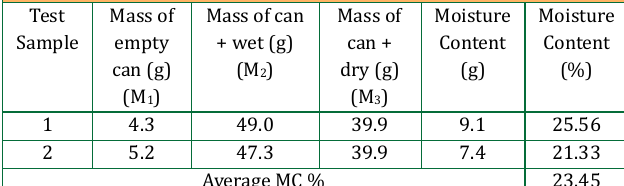
Table 2 (b): Moisture content test results for sample point